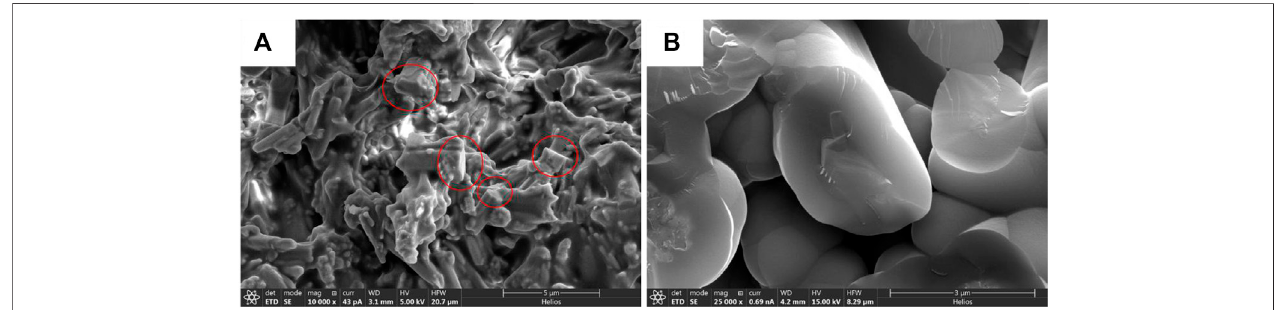
FIGURE 11 | Typical fracture morphology of Si 3 N 4w /Si 3 N 4 : (A) low magni fi cation SEM photo; (B) high magni fi cation SEM photo.